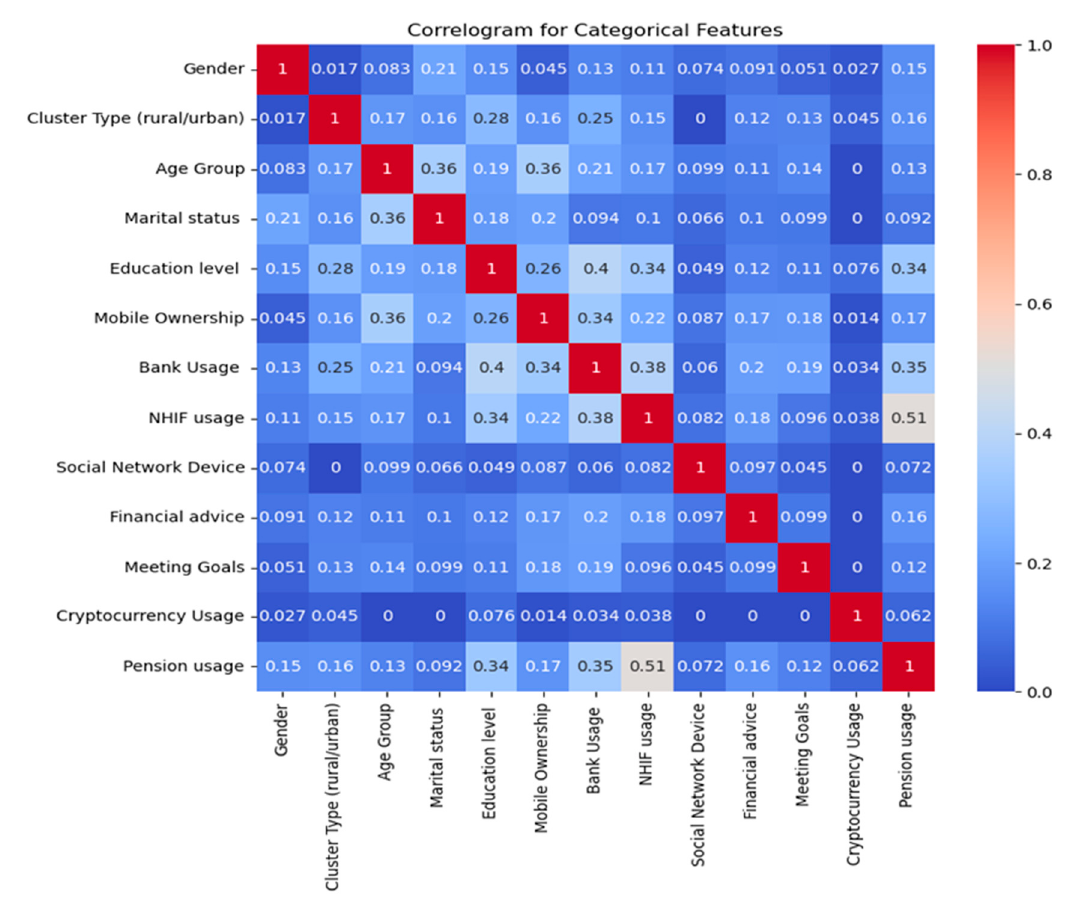
Figure A4. Correlogram for categorical features.